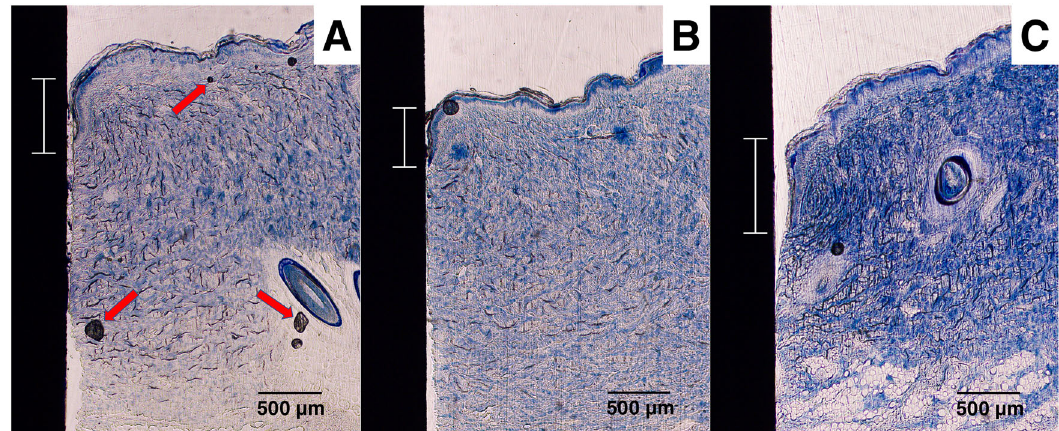
Fig. 13 Examples of histology slides for the Ti surfaces: A Unmodi fi ed Ti, B Ti + HA, C Ti + ZrP. The Epidermal Downgrowth (shown with scale bar) for these samples were A 0.59, B 0.48, C 0.77 mm. Arrows in A show artefacts created by the histology